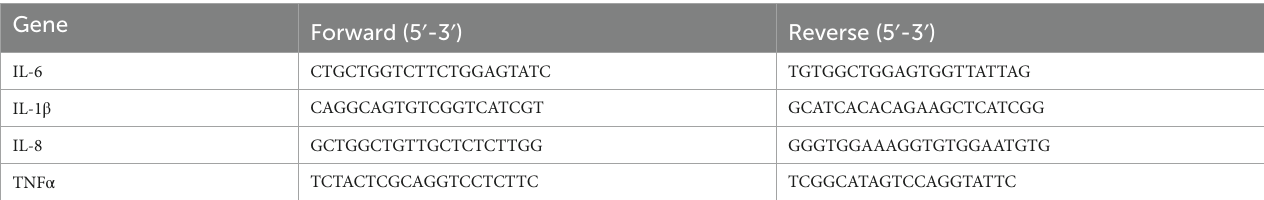
TABLE 1 The primer sequences for quantitative polymerase chain